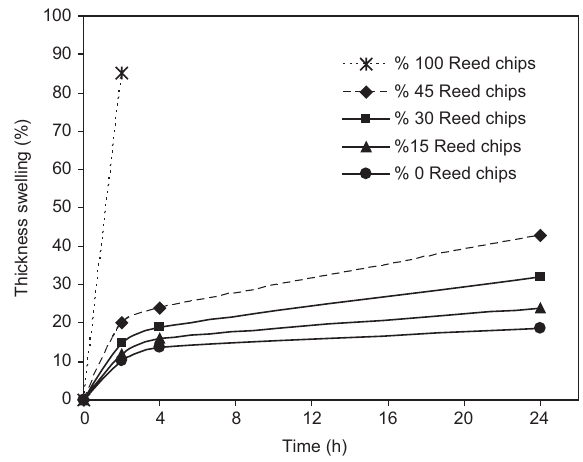
Figure 4 Thermal conductivity of particleboards containing reed chips.